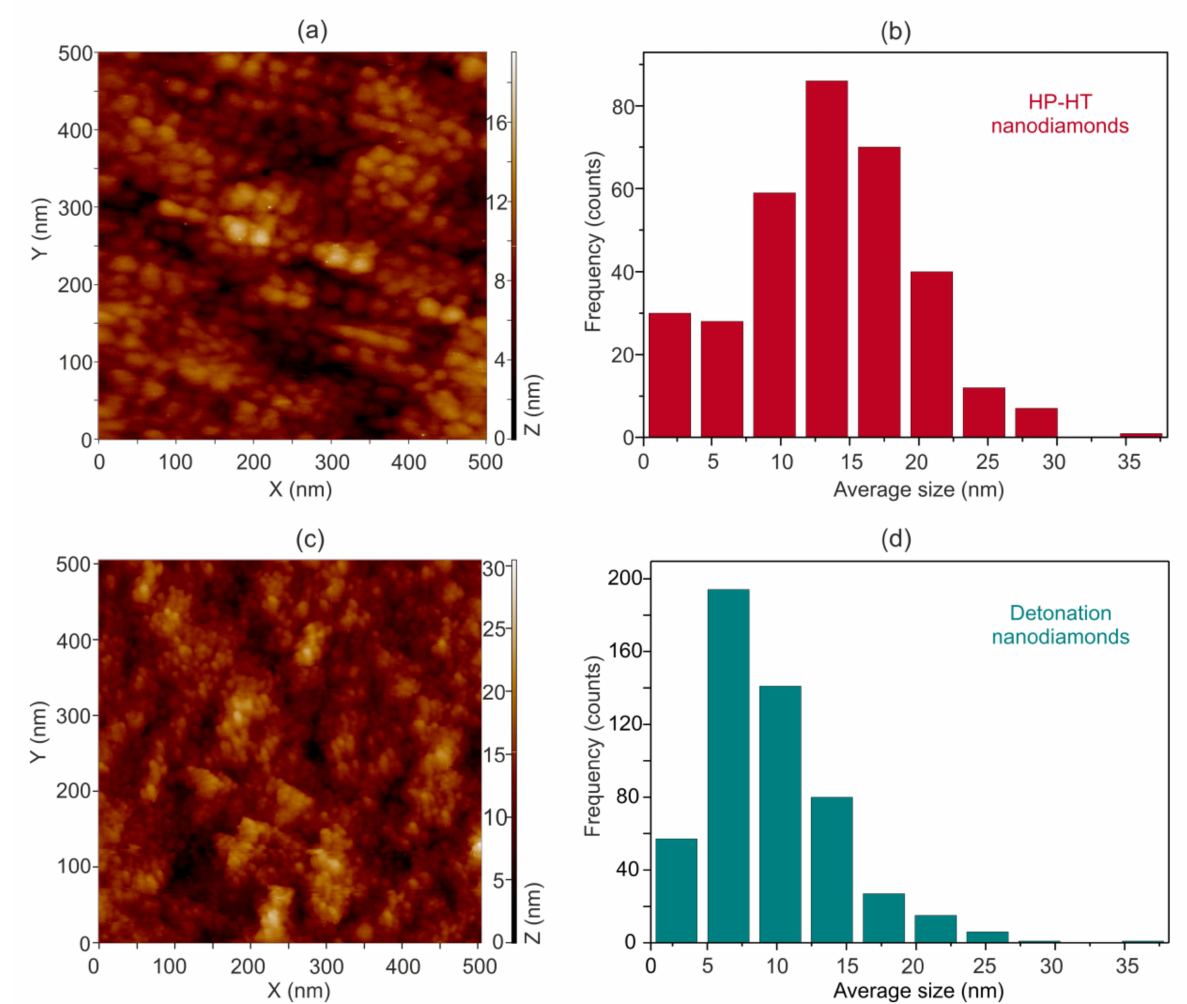
Figure 1. Atomic force microscopy images of ( a ) HP-HT and ( c ) detonation nanodiamond films. The image processing reveals the HP-HT and detonation nanodiamond particle size distributions shown in figures ( b ) and ( d ),